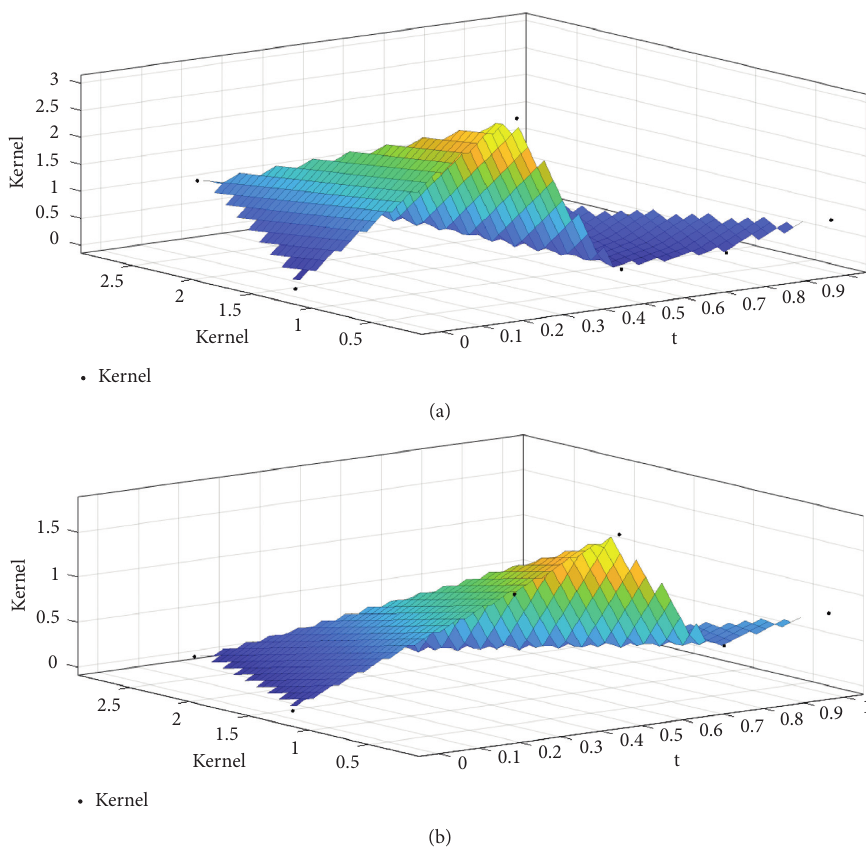
Figure 6: Three-dimensional map of nuclear density in the east-west region. (a) East. (b) West.